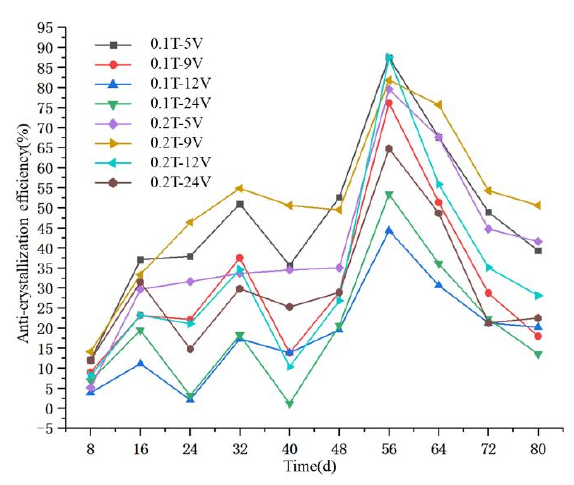
Fig. 11. Changes of anti-crystallization efficiency of the treatment groups under electric and magnetic fields per cycle over time.